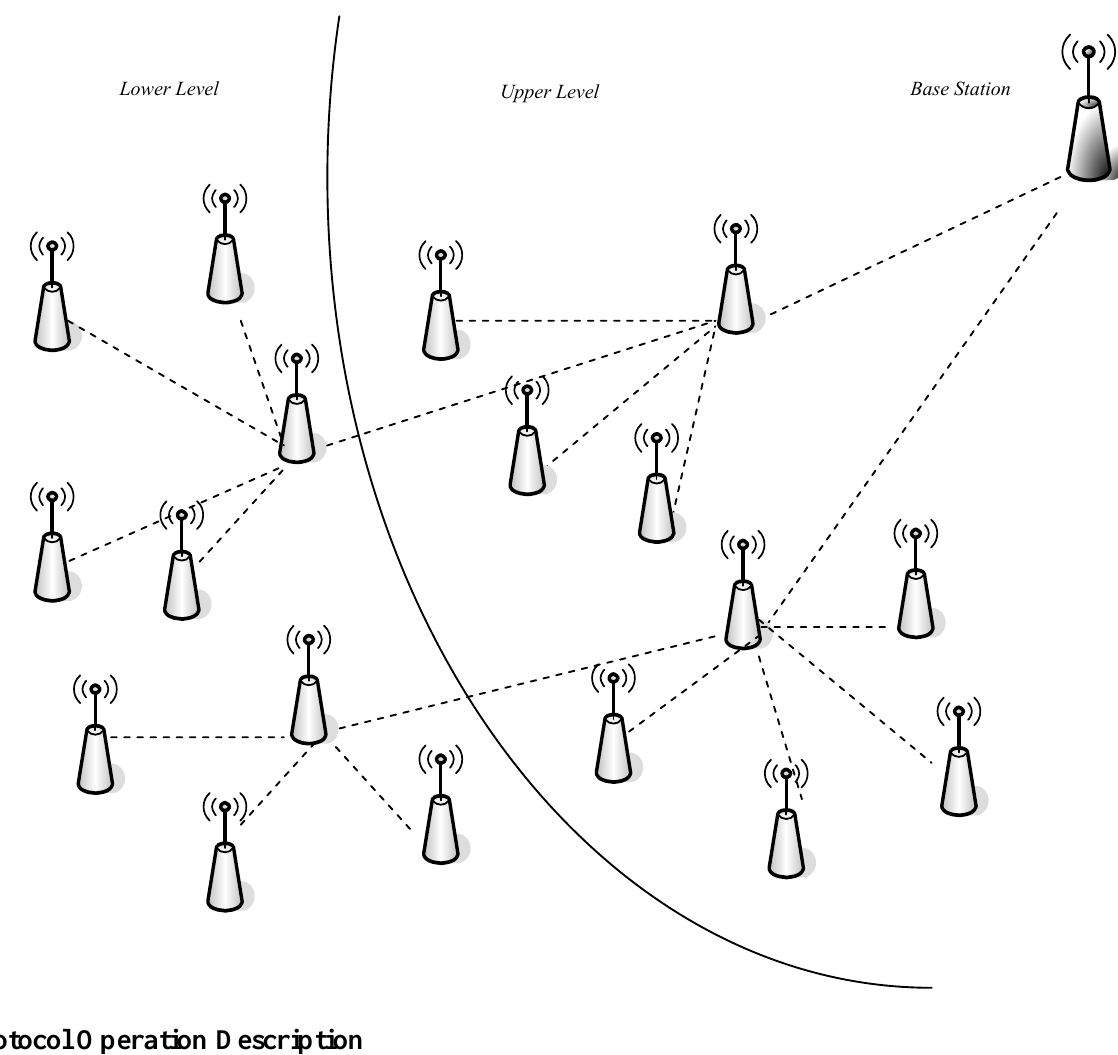
Figure 1. Graphical depiction of the model of the network field adopted in